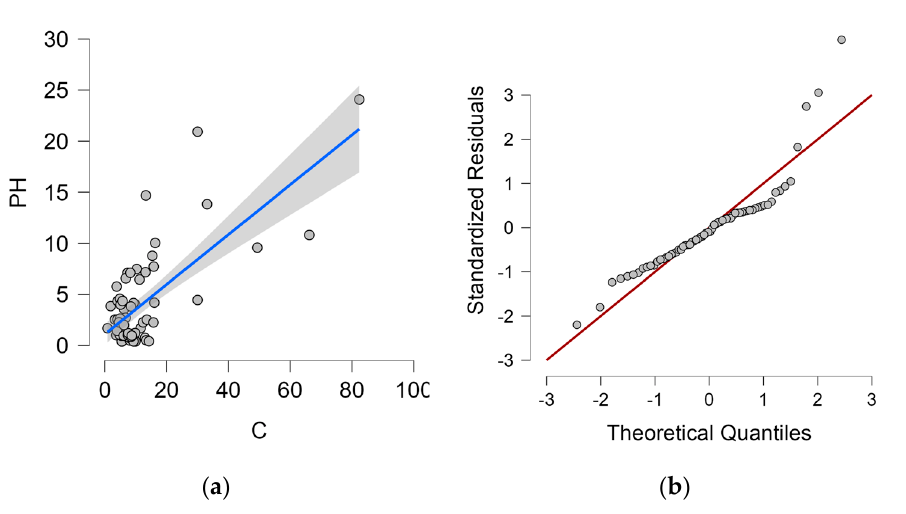
Figure 5. Wet candle method and horizontal dry plate method. ( a ) Dependence of horizontal dry plate method values and 95% confidence interval (grey area) on wet candle method values; ( b ) Q-Q plot. The proposed linear regression analysis model corresponds 50.7% to the value mea- sured by the horizontal dry plate method (PH) and is therefore statistically at a significant level. The Durbin–Watson analysis is close to 2.0 (exactly 2.002), this value controls for correlation between the residuals. Both values can be found in Table